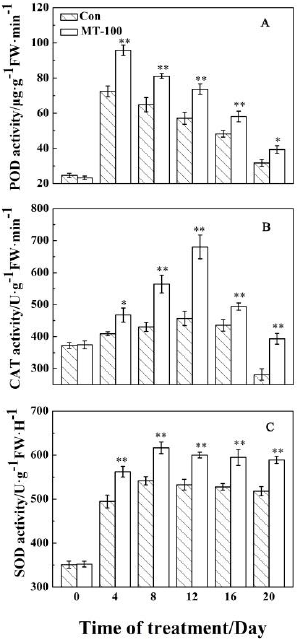
Figure 4. Effects of MT on activity of POD, CAT and SOD in detached grapevine leaves during dark-induced senescence. ( A ) POD activity. ( B ) CAT activity. ( C ) SOD activity. Both of treated and non-treated samples with MT were compared at each time point. ** and * indicate significant differences at levels of 0.01 and 0.05, respectively.